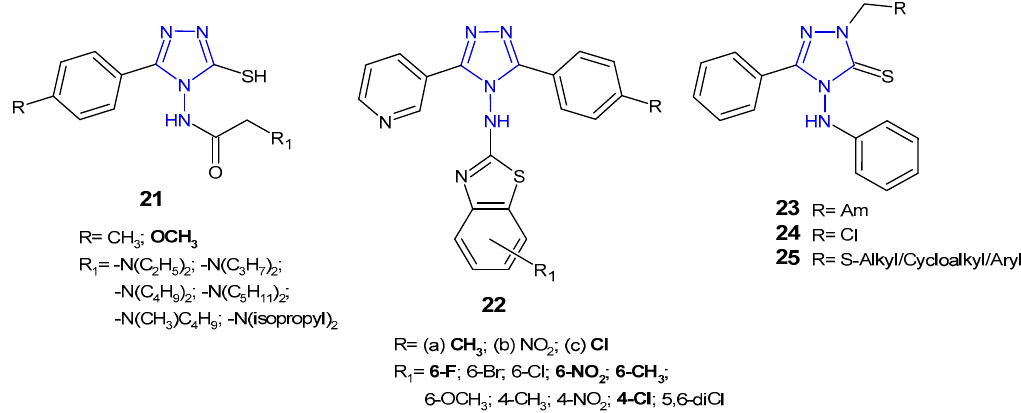
Figure 10. Antibacterial derivatives of acetylated and aromatic amines of 1,2,4-triazole. Patel et al. (2010, 2013) designed 3-(3-pyridyl)-5-(4-substituted phenyl)-4-[ N -(substituted 1,3-benzothiazol-2-yl)amino]-4 H -1,2,4-triazole derivatives 22 (Figure 10) as antibacterial and antituberculosis agents. Preliminary screening showed that among 4- methylphenyl derivatives 22a , compounds containing 6-flouro and 6-methyl substituents at bezothiazole score exhibited activity against Gram-positive bacteria ( S. aureus and S. pyogenes ), which was equal or even higher than in the case of ampicillin, used as a standard, while compound with 6-nitro substituent showed pronounced activity against Gram-negative bacteria ( E. coli and P. aeruginosa ), which was 4- to 8-fold higher than in the case of the standard drug. Moreover, 4-methylphenyl 22a and 4-chlorophenyl triazoles 22c with 4-chloro substituent on the benzothiazole ring showed potent antitubercular activity [39,40]. In 2016, a team of Egyptian scientists studied antibacterial activity of a new series of Mannich bases 23 , chloromethyl 24 and sulfide derivatives 25 (Figure 10) of 4-anilino-5- phenyl-4 H -1,2,4-triazole-3-thiol against one Gram-positive bacterium ( B. cereus ) and two Gram-negative bacteria ( P. aeruginosa and E. coli ). Mannich bases 23 containing morpholine and piperidine moieties exhibited potent inhibitory effect against all types of bacteria, while sulfides 25 showed good activity against Bacillus cereus . The E. coli strain was found to be the most sensitive to chloromethyl compound 24 [41]. 2.3. Antibacterial Activity of Schiff Bases of 4-Amino-1,2,4-Triazole Derivatives Schiff and Mannich bases of 5-(1-adamantyl)-4-amino-2,4-dihydro-3 H -1,2,4-triazol- 3-thione 26 (Figure 11) were screened by Al-Omar et al. (2010) for their antibacterial activity against Gram-positive ( S. aureus , B. subtilis , M. luteus ) and Gram-negative bacteria ( E. coli , P. aeruginosa ). The results of the diameter of growth inhibition zones identified most antibacterial active compounds, which were then examined by minimum inhibitory concentration (MIC).